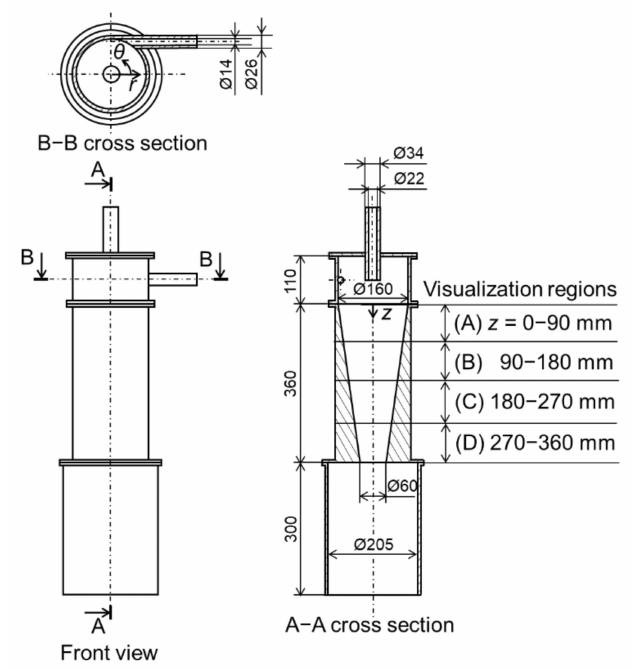
Figure 2. Schematic detailed view of the CO 2 cyclone